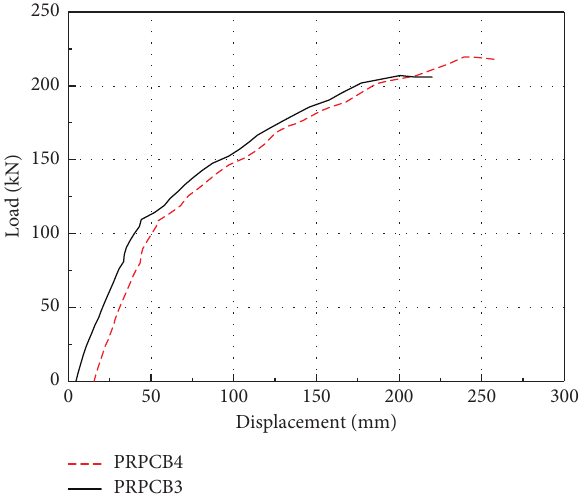
Figure 16: Midspan deformation curves of the specimens with different